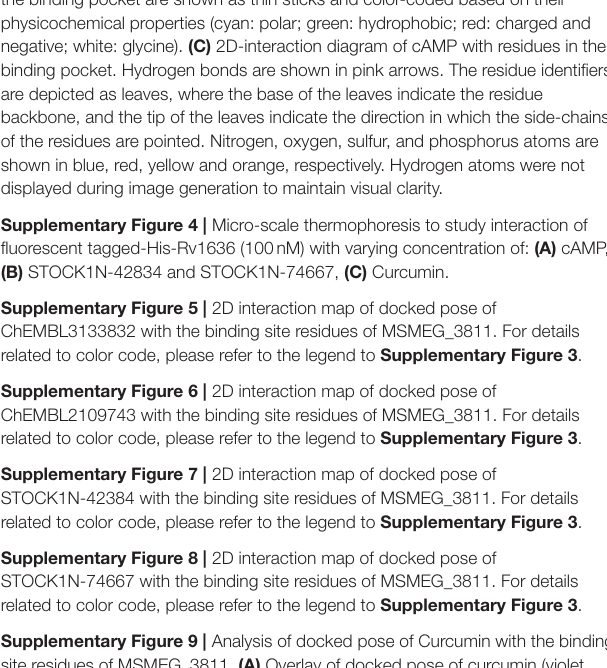
Supplementary Figure 1 | Structural comparison of apo Rv1636 (PDB code: 1TQ8) and cAMP bound MSMEG_3811 (PDB code: 5AHW). (A) Superimposition of chain C of 5AHW (cyan cartoon) on to chain A of 1TQ8 (violet cartoon). The overall RMSD between the aligned residues in these two chains as calculated